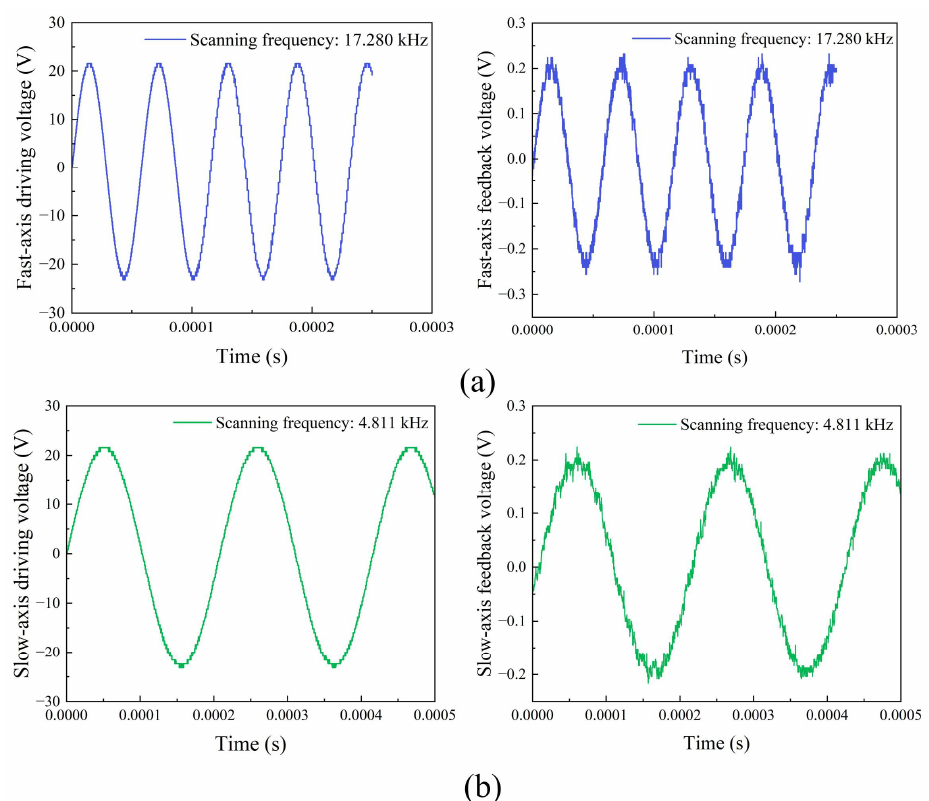
Figure 8. Driving voltage signal (Left) and feedback voltage signal from the built-in angular sensor (Right) for ( a ) fast-axis scanning ( b ) slow-axis scanning.